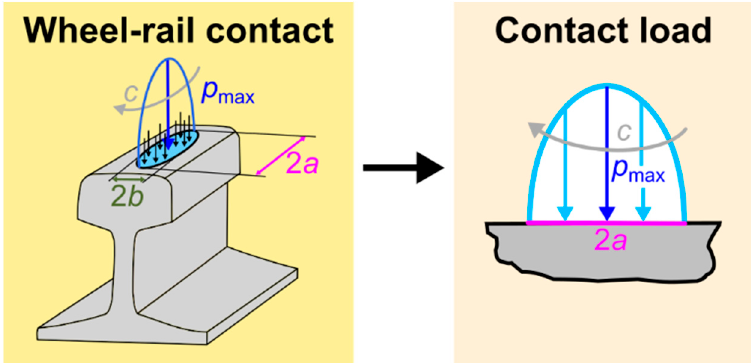
Figure 3. Definition of p max , c and 2 a for an elliptical contact patch with width 2 b . Note: the contact pressure distribution shown in the figure is schematic and refers to a quasistatic load case. The computations consider the development of slip during contact.